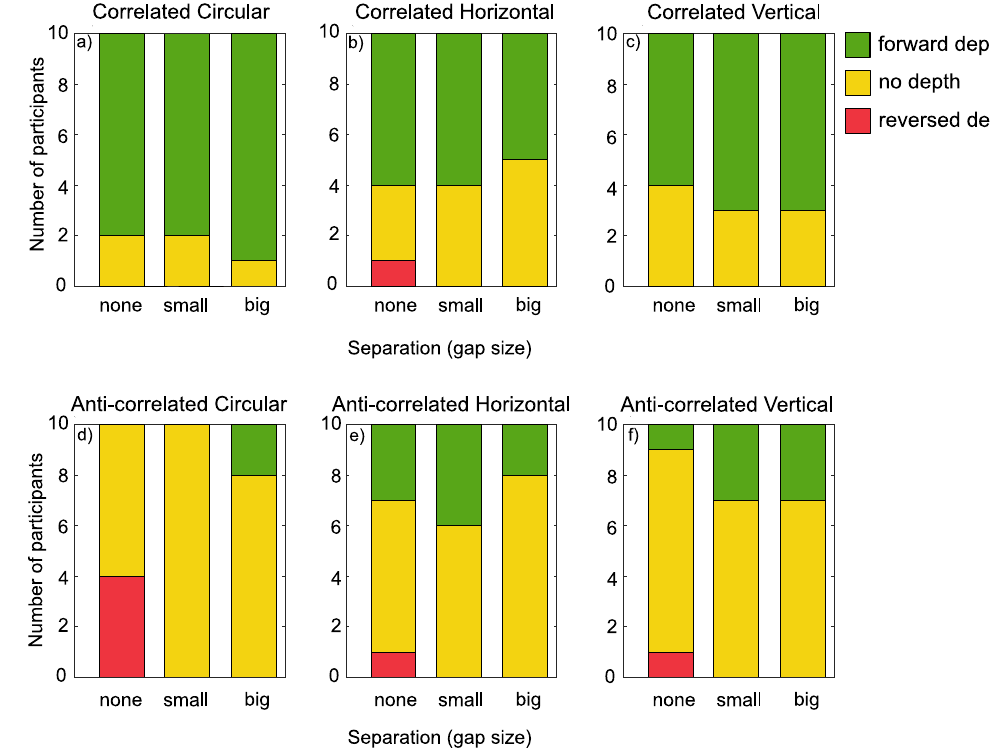
Figure 8. The number of participants reporting forward (green) reversed (red) or no (yellow)